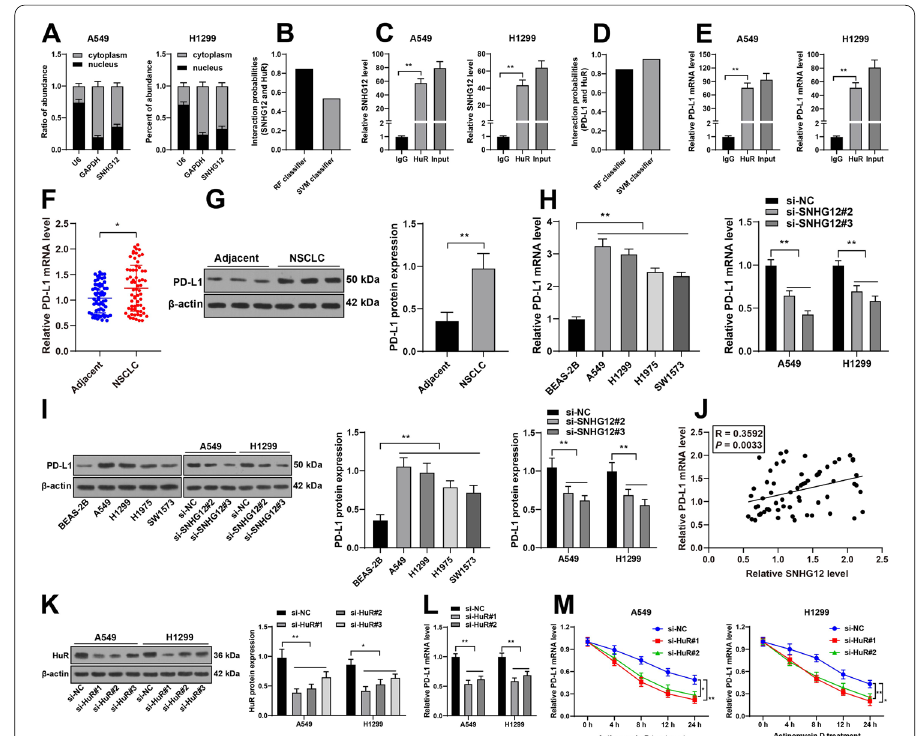
Fig. 4 lncRNA SNHG12 bound to HuR to increase mRNA stability of PD-L1. A Localization of lncRNA SNHG12 in NSCLC cells was analyzed via the subcellular fractionation assay; B probability of lncRNA SNHG12 binding to HuR was predicted via the RNA–Protein Interaction Prediction (RPISeq) database; C the binding relationship between SNHG12 and HuR was analyzed using RIP assay; D probability of HuR binding to PD-L1 was predicted via the RPISeq database; E the binding relationship between PD-L1 and HuR was analyzed using RIP assay; F – I PD-L1 expression in NSCLC tissues and cells was measured via RT-qPCR and western blotting; J correlation between lncRNA SNHG12 and PD-L1 was analyzed via Pearson correlation analysis; A549 or H1299 cells were transfected by three strands of HuR siRNA (si-HuR), with si-NC as the negative control; K protein expression of HuR was detected via western blotting; L , M expression and half-life period of PD-L1 mRNA were determined via RT-qPCR. N 65, cell experiments were performed three times, * P < 0.05, = ** P < 0.01. Data in A – E , G – I , and K – M are represented as mean standard deviation. Pairwise comparisons ± in F and G were analyzed using t -test; multigroup comparisons in C , E , H , and I were analyzed using one-way ANOVA, and in H , I , and K – M were analyzed using two-way ANOVA, followed by Tukey’s multiple